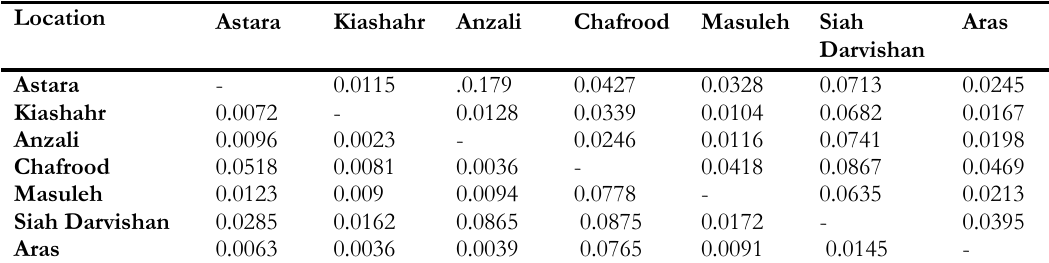
between populations of A. leptodactylus (above diagonal) and T ABLE 5. Pairwise estimates of F ST for each population pair (below diagonal) values of D A